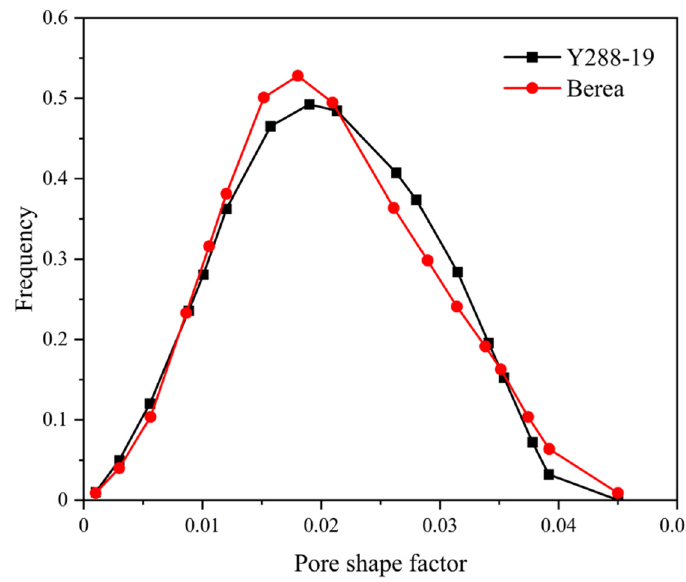
Figure 12. Pore shape factors of two types of cores.